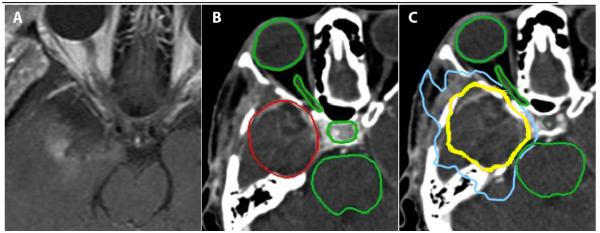
(A) Axial T1-weighted post contrast MRI illustrating a right-sided temporal lobe high-grade glioma resection cavity bordering the right optic nerve, optic chiasm and brainstem. (B) Planning Axial CT image. The radiosurgical planning treatment volume is contoured in red and critical structures are contoured in green. (C) Planning Axial CT illustrating the prescription isodose line in yellow and the 50% isodose line in blue.